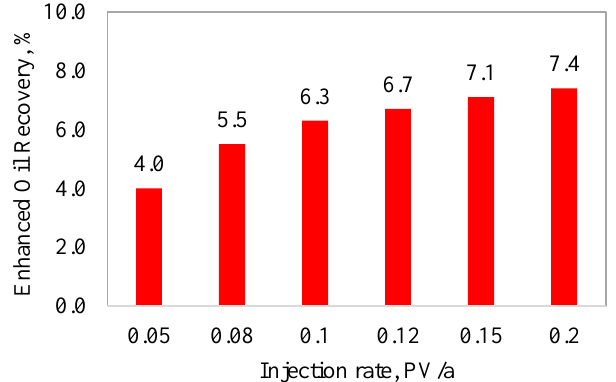
Figure 7—Numerical simulation of the effect of the injection rate on oil recovery.